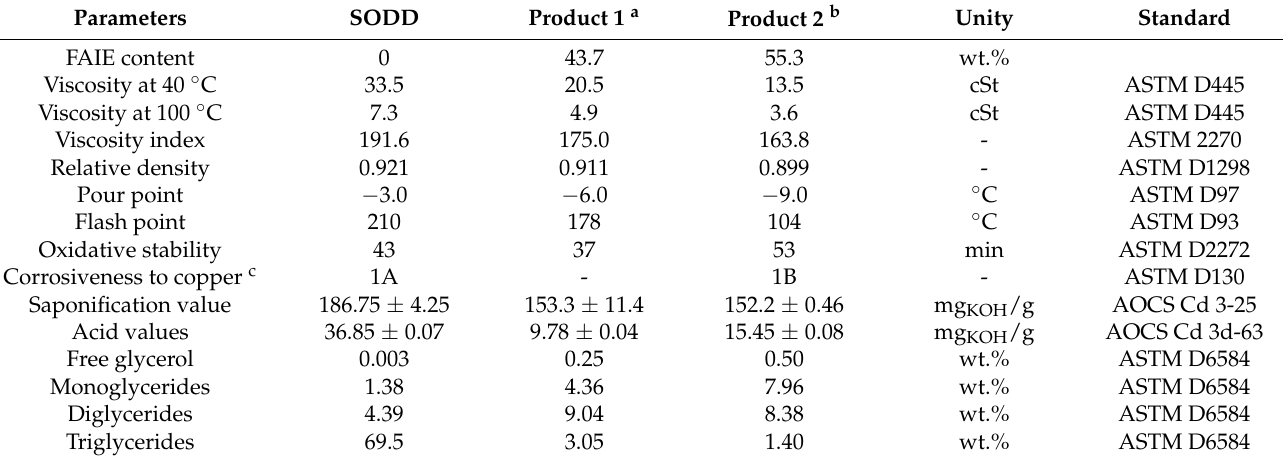
Table 4. Physicochemical properties and chemical composition of the SODD and the esterifica- tion/transesterification reaction products containing different content of fatty acid isoamyl es- ters